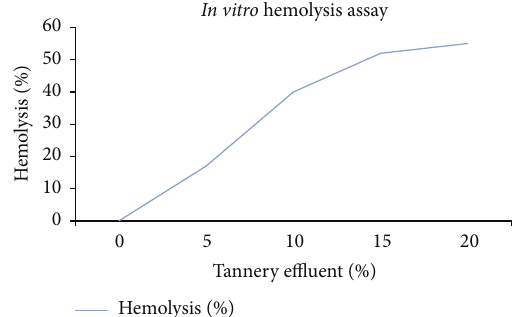
Figure 2: Percentage of hemolysis in In vitro Hemolytic Assay indicating the concentration of tannery effluent that can cause 50% of